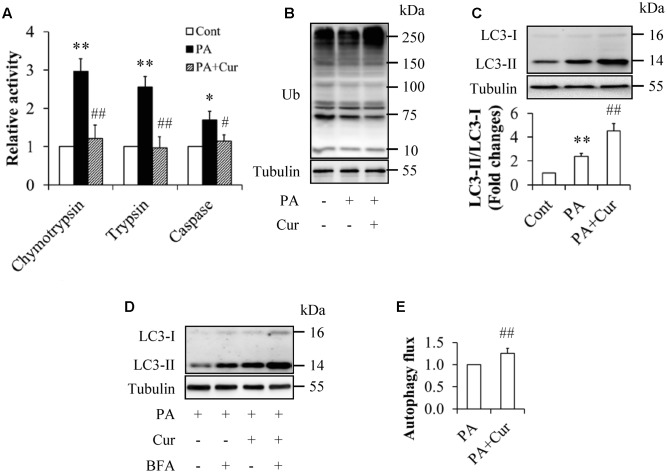
Curcumin inhibited the UPS and activated autophagy in HUVECs. (A) Inhibition of peptidase activities of 20S proteasome by curcumin (Cur). (B) Effect of Cur on total protein ubiquitination. (C) Enhancement of LC3 levels by Cur. (D,E) Increased autophagy flux by Cur. N = 4. ∗p < 0.05, ∗∗p < 0.01 vs. control group; #p < 0.05, ##p < 0.01 vs. PA-treated group.